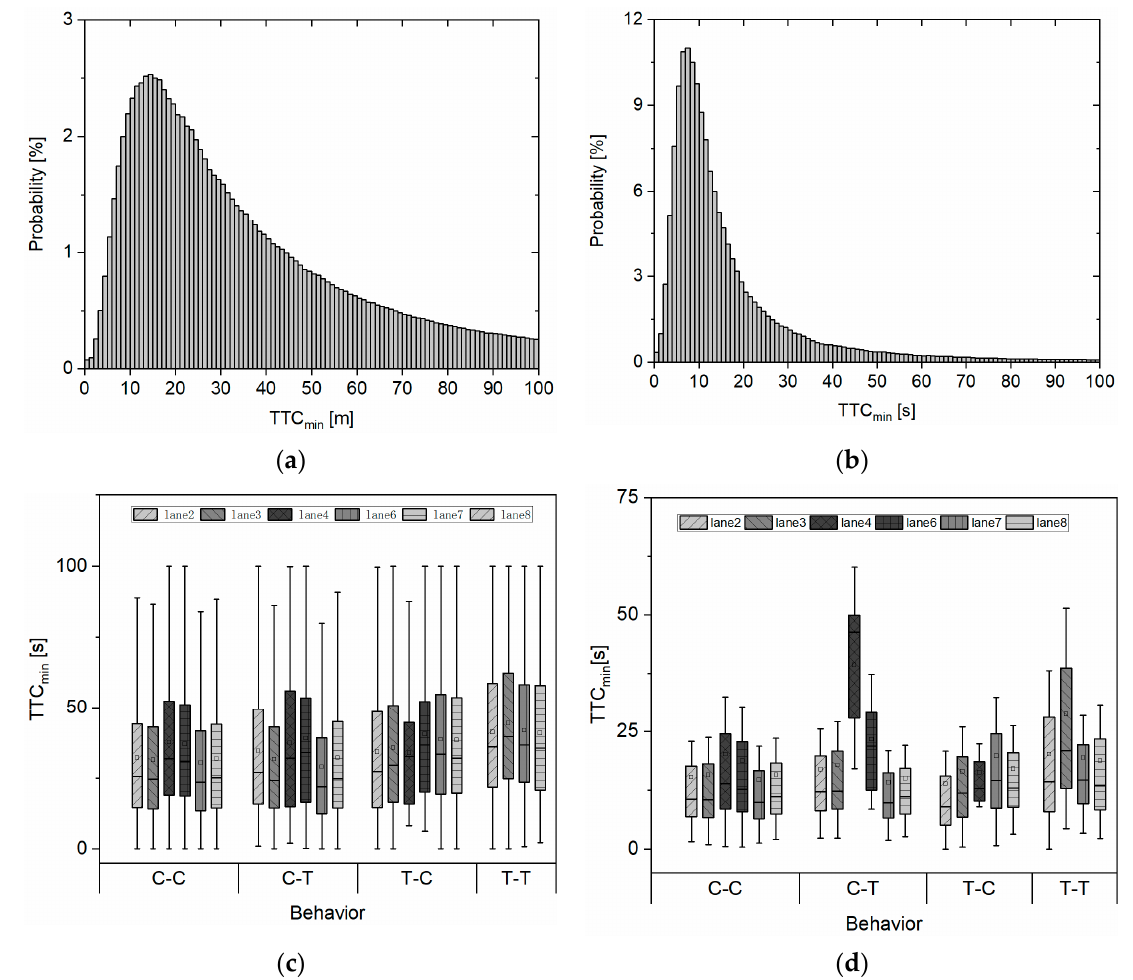
Figure 12. Probability distribution of TTCmin when car following ( a ) and lane changing ( b ); TTCmin when car following ( c ) and lane changing ( d ) for different following behavior in different lanes.